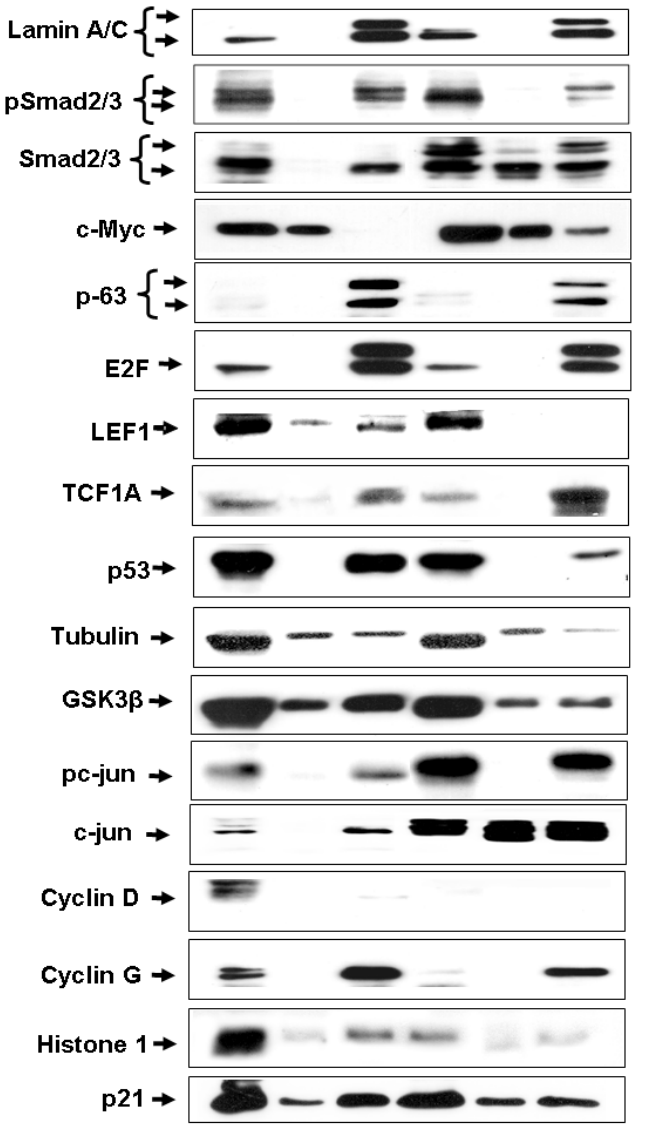
Figure 5. Cellular distribution of transcription factors in the MCF7 and C4.12.5 cell lines. Cell lines were fractionated as described under Materials and Methods and total lysates (T; 80  g), cytosolic fractions (C; 20  g), and nuclear extracts (N; 20  g) were resolved on 10% SDS-PAGE and blotted with the indicated